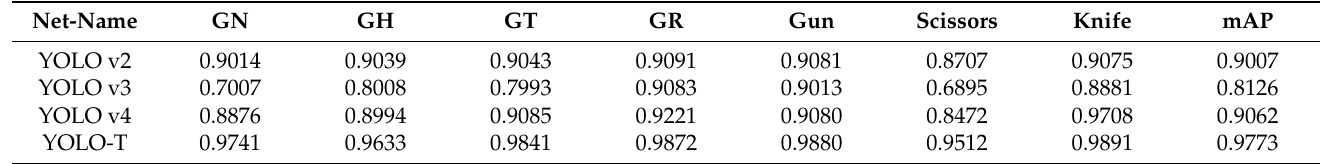
Table 1. Comparison of accuracy of different deep learning networks.